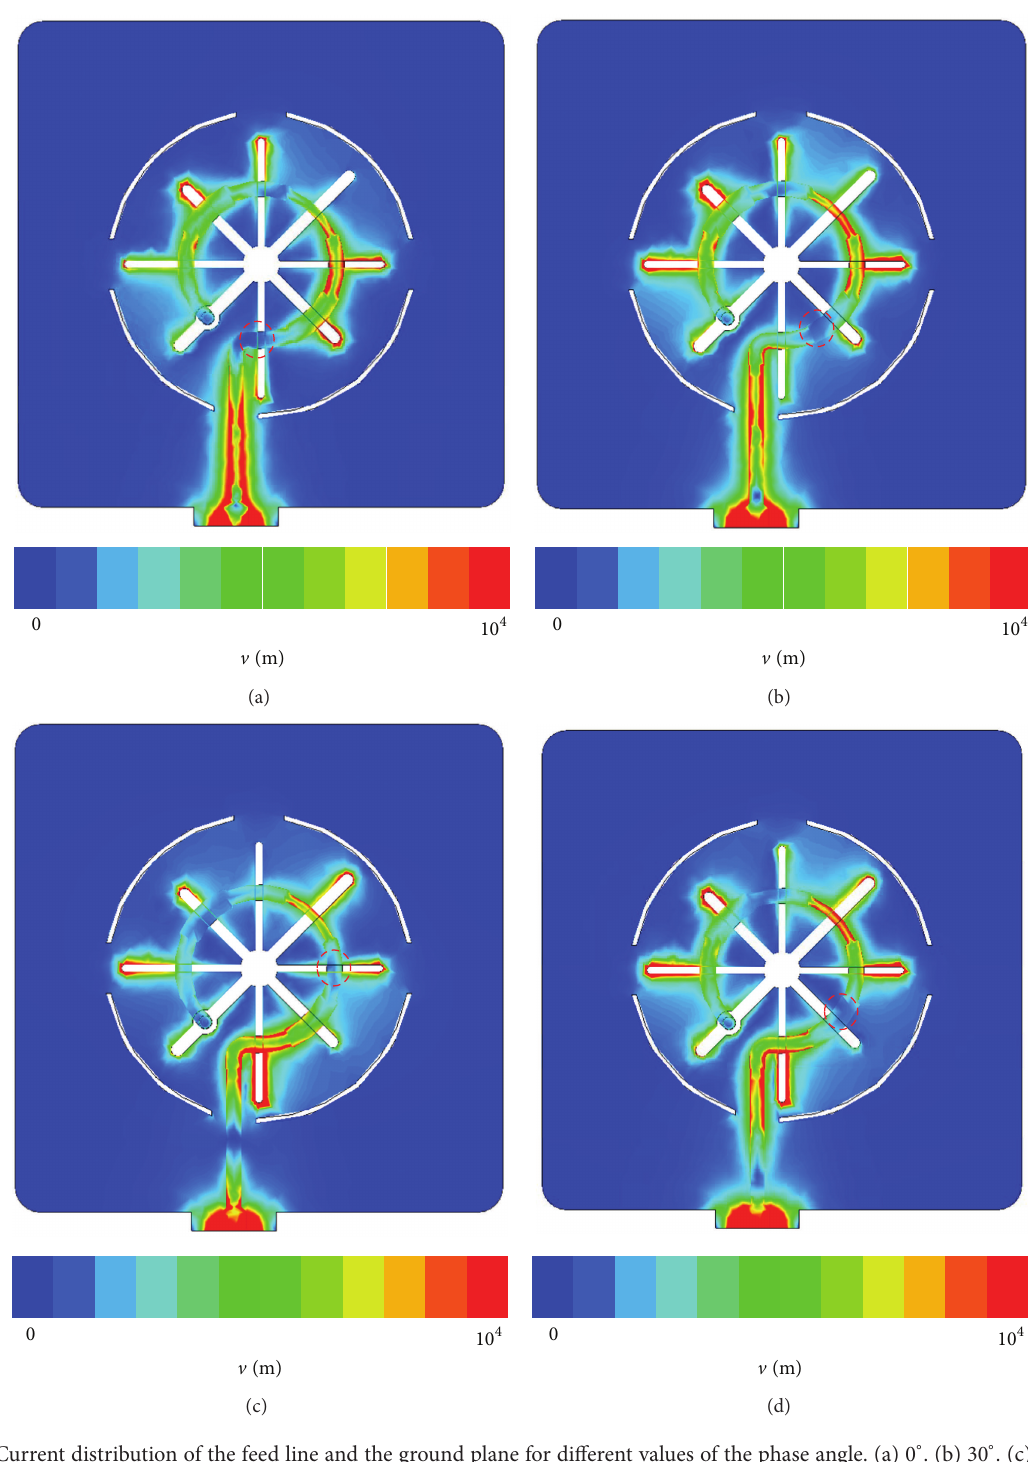
Figure 3: Current distribution of the feed line and the ground plane for different values of the phase angle. (a) 0 ∘ . (b) 30 ∘ . (c) 60 ∘ . (d) 90 ∘ . (The red circle shows the minimum current on the microstrip